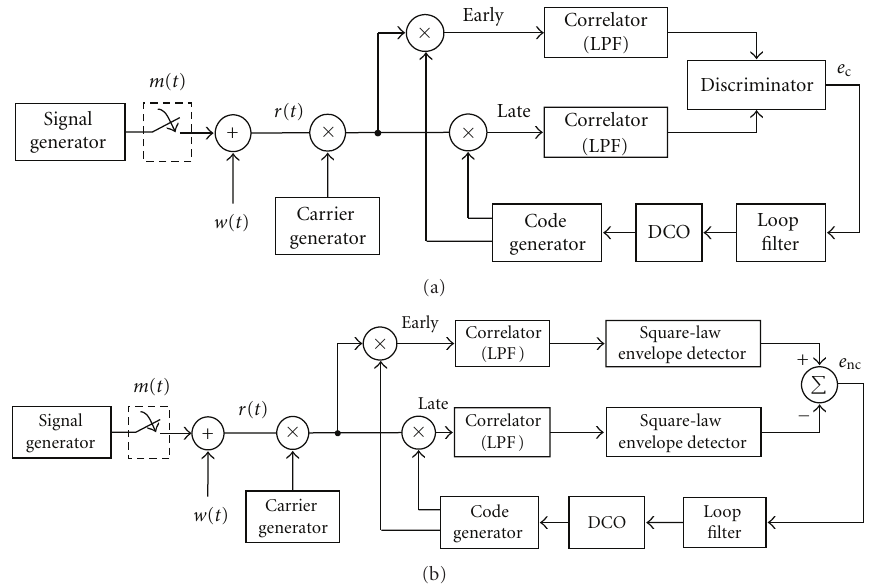
Figure 1: (a) Block diagrams of c-DLL; (b) block diagrams of nc-DLL.